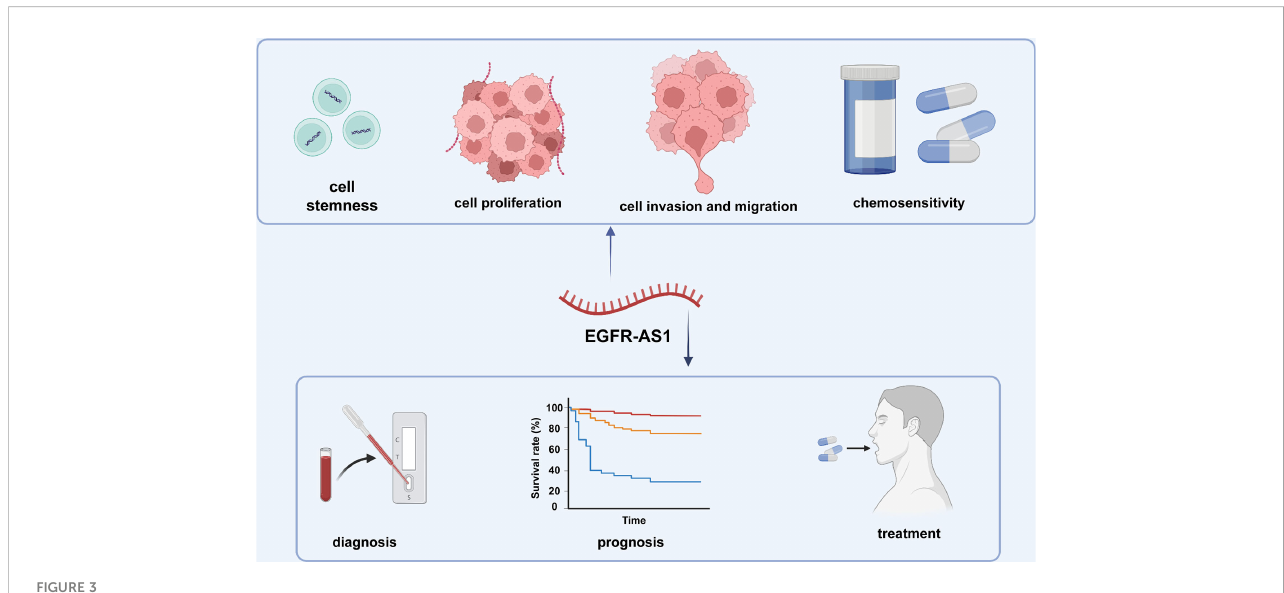
FIGURE 3 The clinical applications of